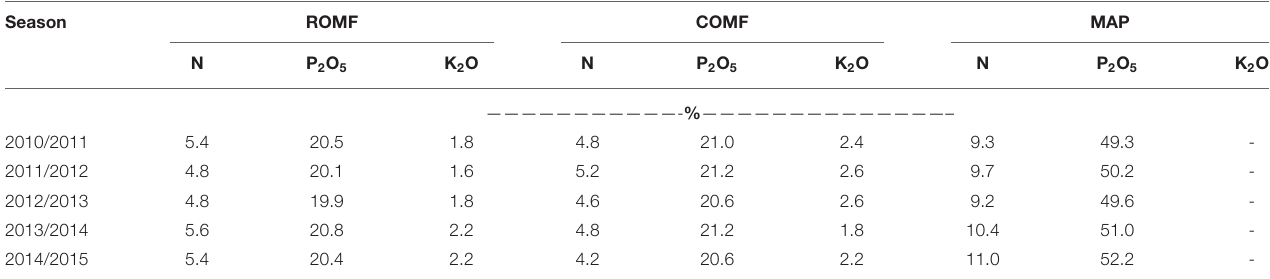
TABLE 2 | Fertilizers characterization.